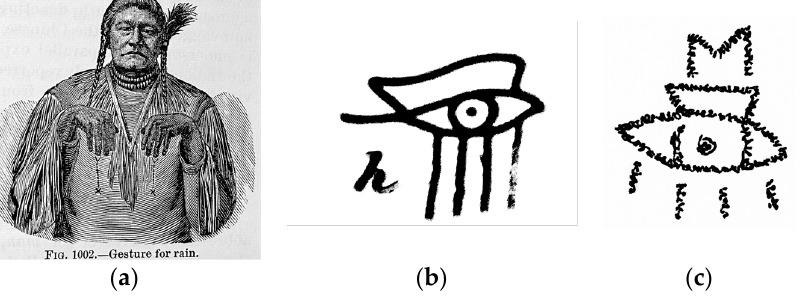
Figure 28. ( a ) Indian sign gesture for “rain”. (Mallery 1881, Figure 114; 1893, Figure 1002). ( b ) Egyp- tian character for “weep”. (Mallery 1881, Figure 142; 1893, Figure 999.h; after Champollion 1836). ( c ) Western Message Petroglyph picture-writing image (Ogden UT; typical).